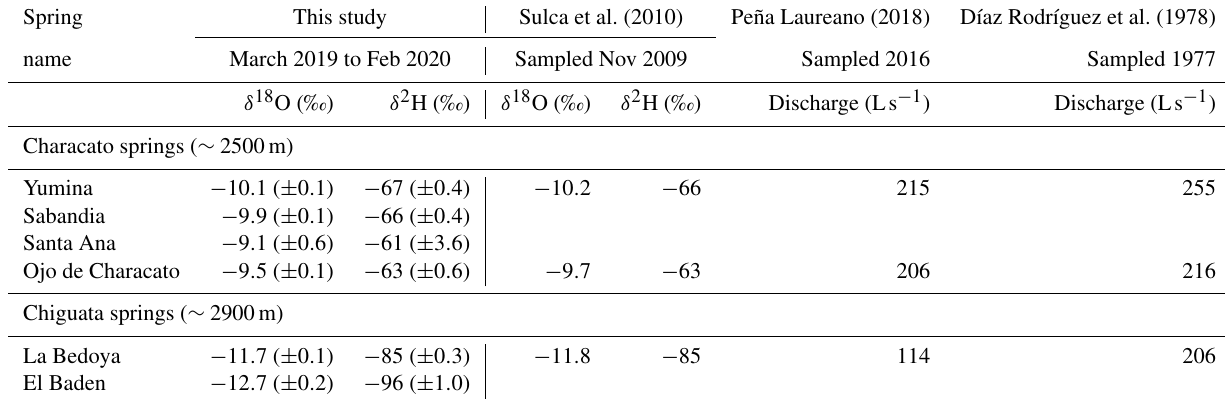
Figure 3. (a) Isotopic composition of springs, rivers, and precipitation sampled in our study area. The LMWL (dashed grey line) estimated for this region was δ 2 H = 8 . 0 δ 18 O + 10 . 9‰. The inset is an adjusted scale to show isotopically enriched dry-season Laguna Salinas surface water (LSA: δ 18 O = 12 . 3, δ 2 H = 28 and MAX: δ 18 O = 16 . 7, δ 2 H = 57) and 2020 amounted weighted average rain values. (b) Deuterium composition with respect to elevation of springs, rivers, Laguna Salinas wet-season surface water, and precipitation. The isotopic composition of dry-season Laguna Salinas surface water has been omitted. Amount-weighted averages of rain are shown with amount-weighted standard deviation error bars and do not show the full range of daily maximum and minimum values. Surface waters in open symbols with the exception of Lagunas Salinas surface waters which are closed for emphasis. Arrows indicate hypothesized mixing lines between high-elevation sources of recharge. Sample classification (NaCl and SO 42 − ) based on chemistry data presented in Sect. 4.2. Table 2. Average isotopic composition for springs sampled from March 2019 to February 2020 and comparison with isotope values of three springs sampled in 2009 by Sulca et al. (2010). Parentheses are standard deviations of all measurements at that site. Discharge from Díaz Rodríguez et al. (1978) compared with measurements in 2016 from Peña Laureano (2018). Spring This study Sulca et al. (2010) Peña Laureano (2018) Díaz Rodríguez et al.